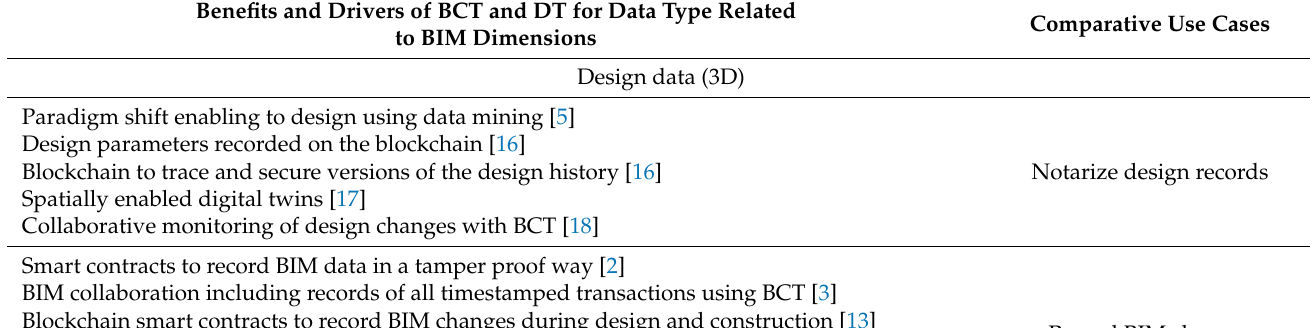
Table 1. Summary of the literature related to project lifecycle data required for BCTDs categorized as per the BIM dimensions. Benefits and Drivers of BCT and DT for Data Type Related to BIM